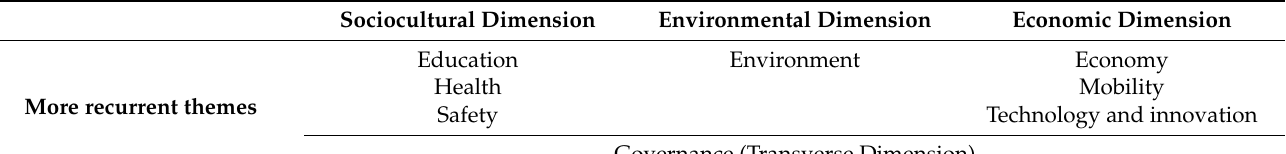
Table 4 consolidates the frequent themes, organizing them according to the dimen- sions of sustainability. In this case, the governance theme becomes transversal to the three dimensions. Table 4. Most frequent themes within the six groups, organized by sustainability